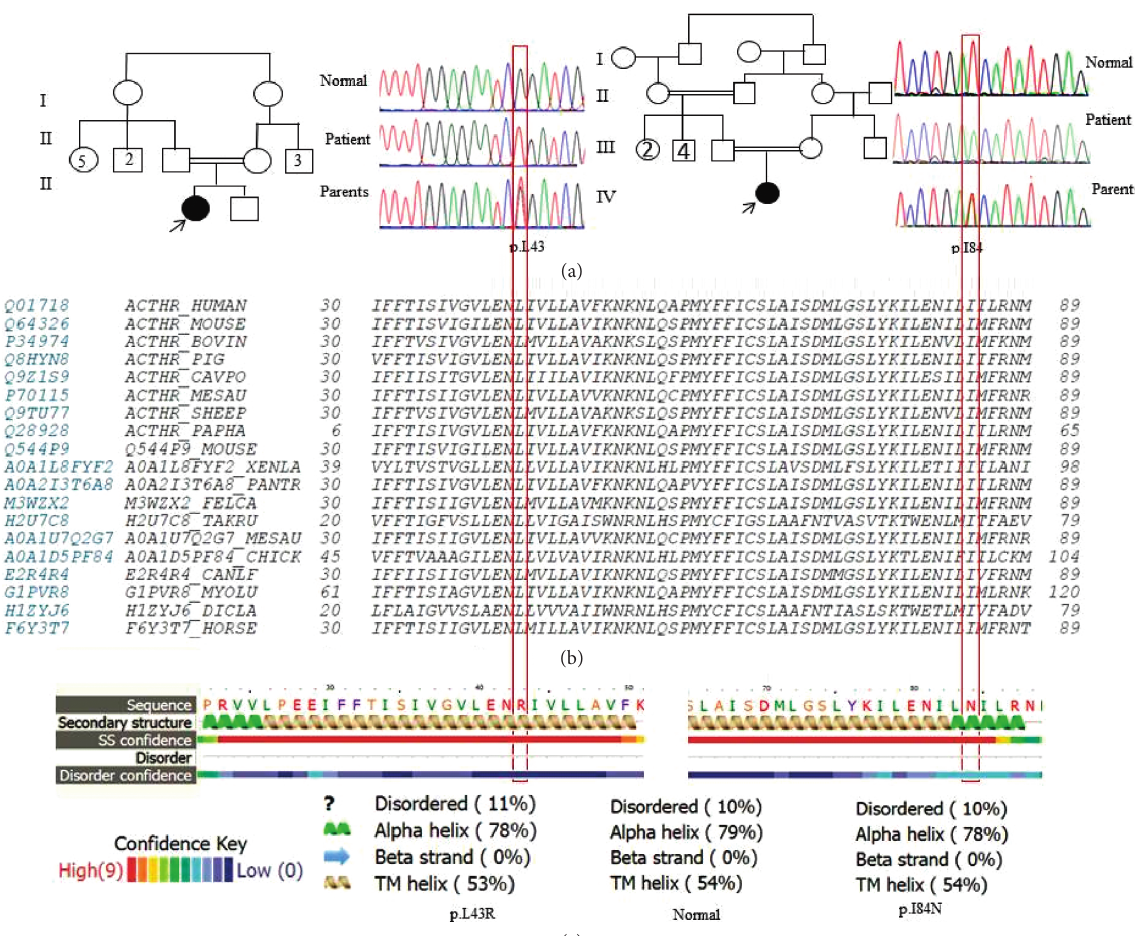
Figure 1: (a) Electropherogram of the patients having novel variants shows homozygote variants at positions c.128T > G and c.251T > A in the MC2R gene, and segregation analysis of the parents is shown. (b) Alignment of the MC2R gene at positions 43 and 84 in different species shows conservation. (c) Phyre structural analysis for p.Leu43Arg and p.Ile84Asn based on disordered and secondary structure effects. The helix does not change, and the influence is very low. The order is changed for p.Leu43Arg more than p.Ile84Asn.